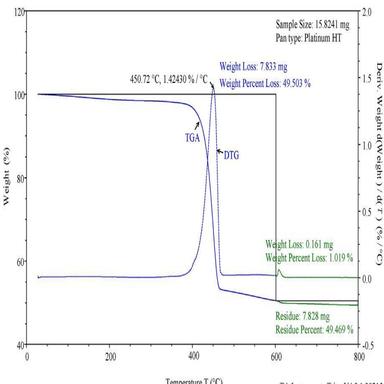
TG/DT analysis on fusion region.